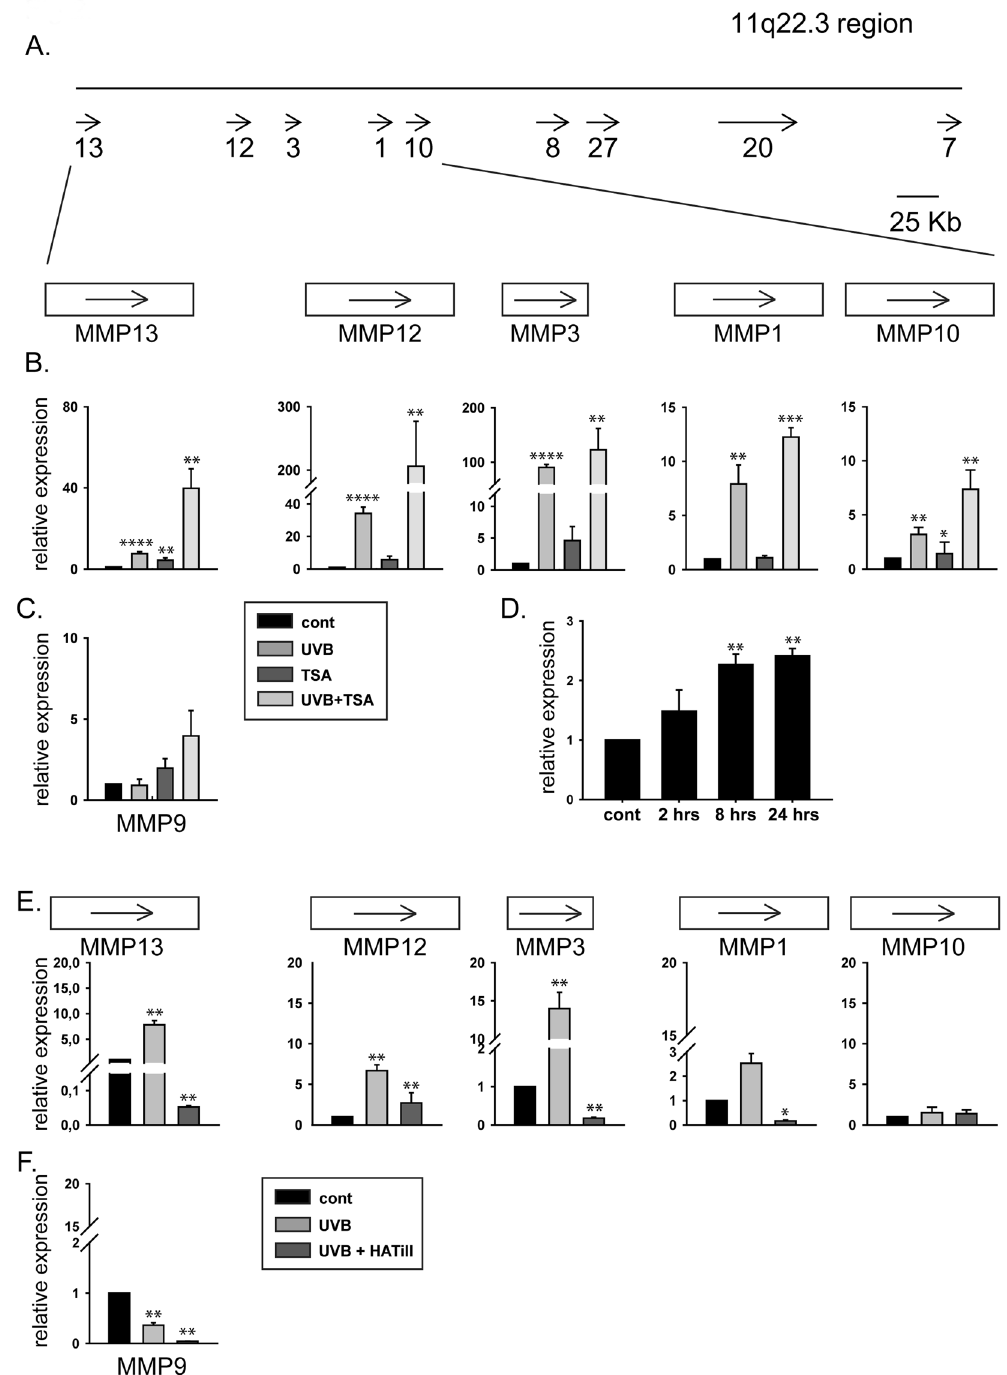
Figure 2. Differential expression of MMP genes located in the 11q22.3 region and MMP9 . ( A ) Schematic drawing of the MMP gene cluster localized at chromosome 11q22.3 based on the NCBI GeneBank database. Arrows represent genes and the orientation of their transcription. Numbers indicate the corresponding MMP genes (e.g., 13 is MMP13 ). The drawing represents only the negative strand of the region. ( B and C ) Expression levels of MMP genes in human keratinocyte cells. HKerE6SFM cells were treated with UVB, TSA or UVB + TSA. The mRNAs were isolated 14 hours after the first treatment, and the expression levels of MMP13 , MMP12 , MMP3 , MMP1 , MMP10 ( B ) and MMP9 ( C ) were analysed by qPCR. The means and standard deviations of six independent experimental triplicates are indicated as fold-expression compared to the control. Star indicates statistical significance between the dataset (paired Anova * P < 0.05, ** P < 0.01, *** P < 0.001, **** P < 0.0001). Legends for the X-axis are control (no treatment), UVB (only UVB no TSA), TSA (only TSA no UVB) and UVB + TSA (both UVB and TSA). ( D ) Pre-mRNA levels of MMP3 . HKerE6SFM cells were treated with 80 mJ/cm 2 UVB. The mRNAs were isolated 2, 8 and 24 hours after the first treatment,